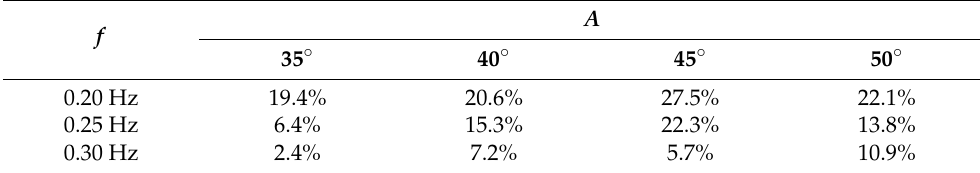
Table 6. Mean thrust comparison of instant mode to conventional nondeformable mode.